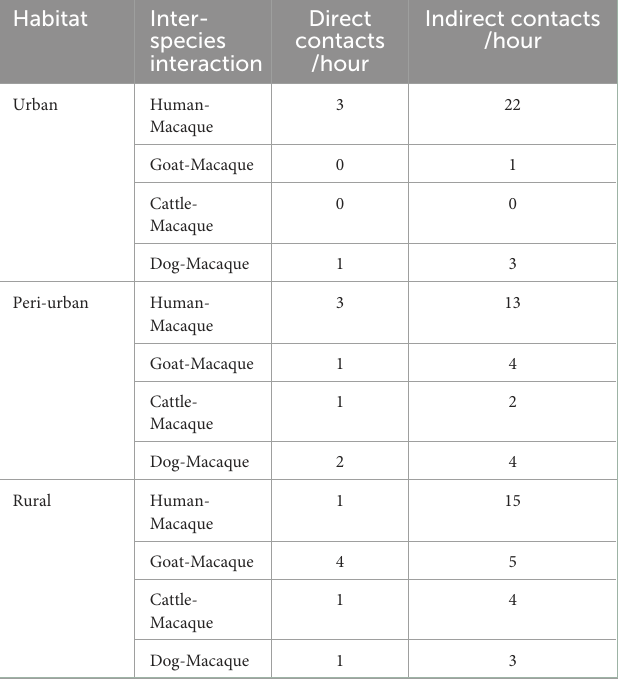
TABLE 7 Contact rate of inter-species interaction.